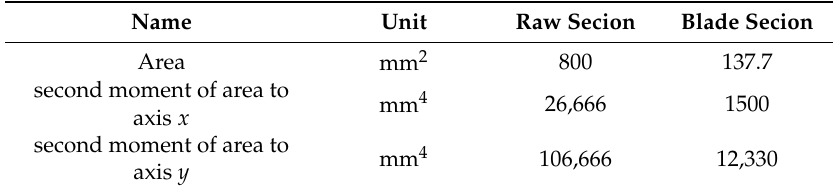
Table 2. Geometrical